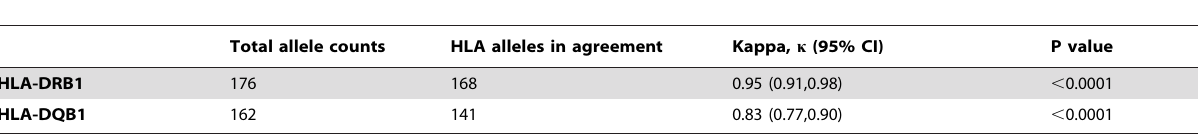
Table 3. Agreement between predicted and directly typed HLA